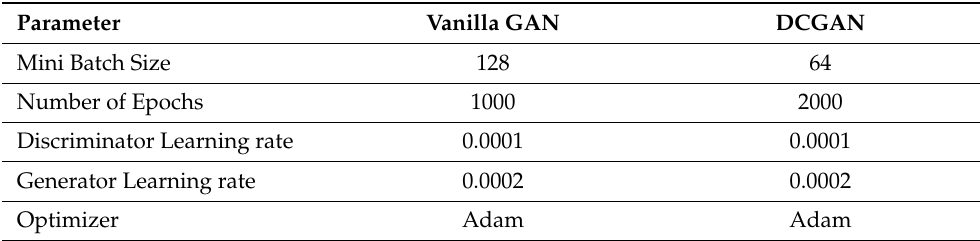
Figure 7. MRI scan images that are generated by applying DCGANs for ( a ) DCGANs no tumor images, and ( b ) DCGANs tumor images. Table 2. Parameter configurations are used to train the Vanilla GAN and the